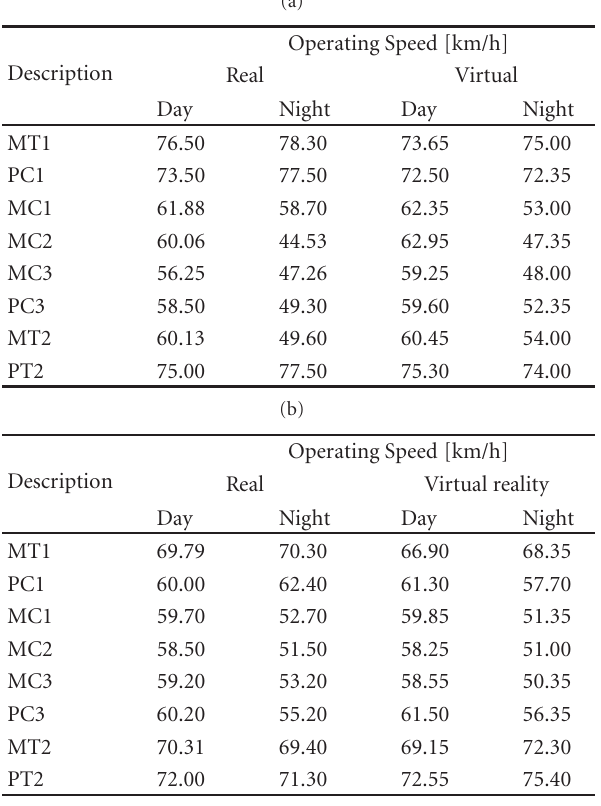
usually higher than the legal speed limit (50 km/h, except for Table 4: Operating speed (S 85 , km/h) measured in daytime and at night, in the real and virtual environments, eastwards (a) and 2 sections, MC2 and MC3, in the westbound direction) but westwards (b). also higher than the real speed. During the day, eastbound speeds of between 58.25 and 72.55 km/h were recorded; in (a) the opposite direction, speeds were within the range 59.25 to 77.30 km/h. During the night, the eastbound speed increased to between 50.35 and 75.40 km/h, while the westbound speed varied between 47.35 and 75.00